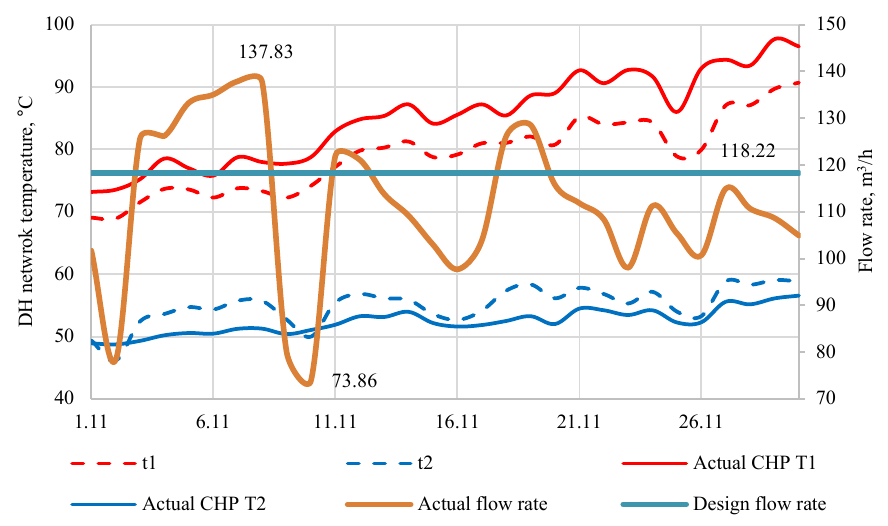
Fig. 2. Temperature and flow rates profiles at a DH